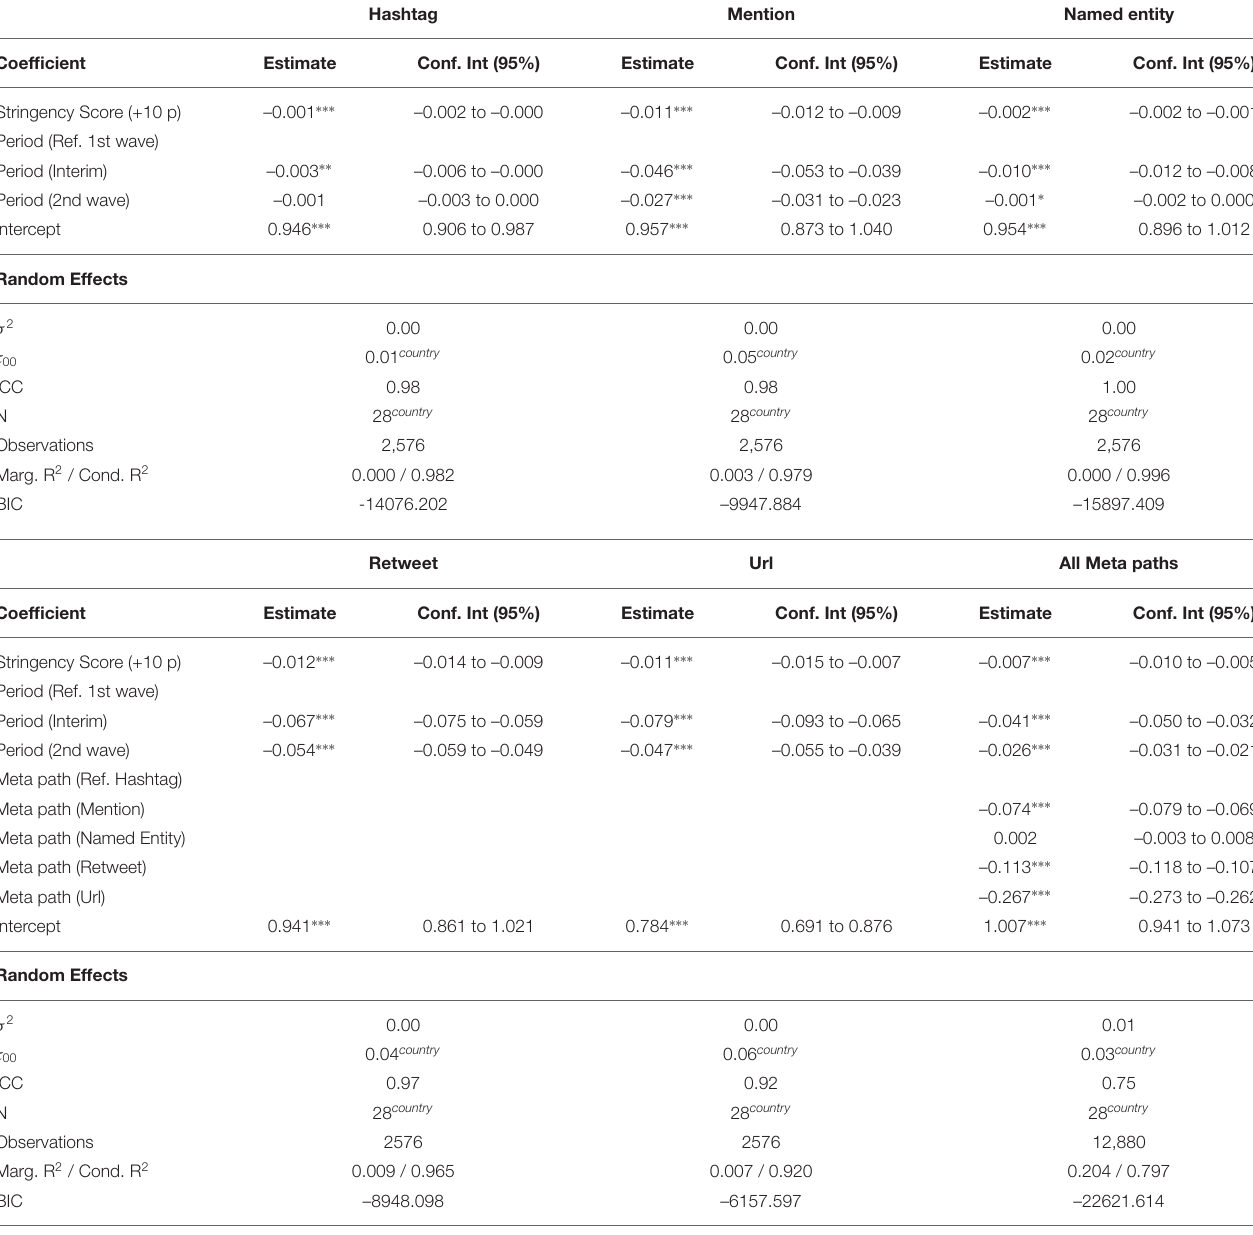
TABLE 2 | Linear mixed effects models for each meta path and for a composition of all